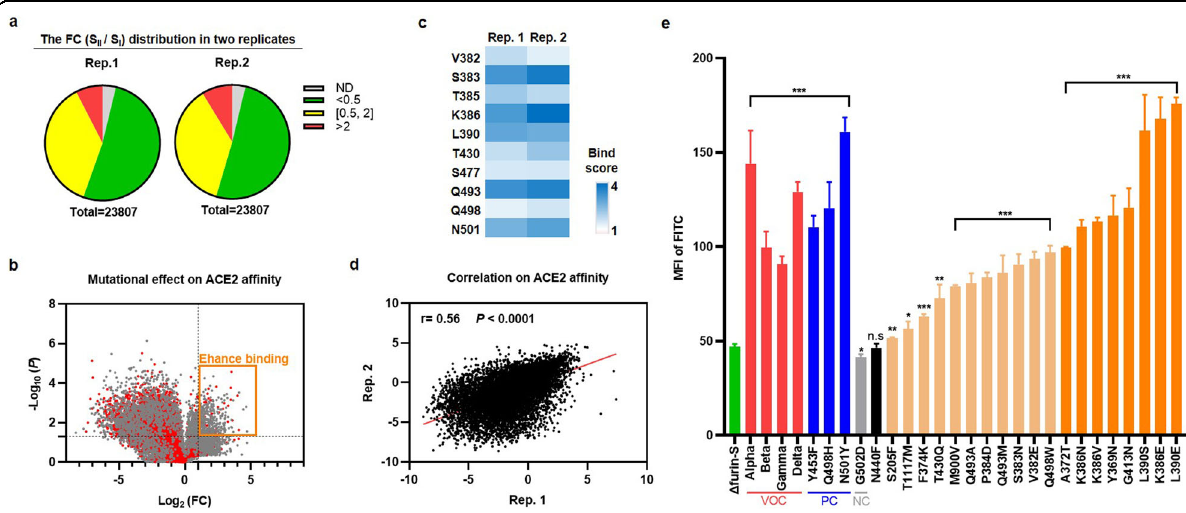
Fig. 2 The mutational landscape and top-ranked sites validation of S variants. a The pie chart of the FC (S II / S I ) distribution in two replicates (named Rep.1 and Rep.2). Mutational types of ND, FC < 0.5, 0.5 ≤ FC ≤ 2, and FC > 2 were colored in gray, green, yellow, and red, respectively. b The volcano plot of the mutational effect on ACE2 af fi nity. The x -axis indicated the log 2 (FC) and the y -axis indicated the – log 10 ( P ). The gray and red dots represented the mutations on non-RBD and RBD region, respectively. The orange rectangle represented the “ Enhance binding ” mutational types that signi fi cantly heighten the af fi nity with ACE2, with the FC > 2 and P < 0.05. c The top ten hotspot residues on the RBD that were both enriched in two replicates, with the bind score >1. d The correlation analysis of log 2 (FC) in two replicates for the ACE2 af fi nity, with a Pearson coef fi cient r = 0.56, P < 0.0001. e The evaluation of 20 candidates. The MFI of FITC in the VOCs (Alpha, Beta, Gamma, and Delta) was shown in red column and that in the Δ furin-S was shown in green column. Y453F, Q498H, and N501Y mutants were set as positive control (PC, blue column) while G502D mutant was set as negative control (NC, gray column). One site with no signi fi cance (n.s.) was shown in black column. Eleven tighter sites were shown in pale brown column and the eight tightest sites were shown in orange column. The t -test analysis was indicated as: n.s., P > 0.05, * P < 0.05, ** P < 0.01, *** P <